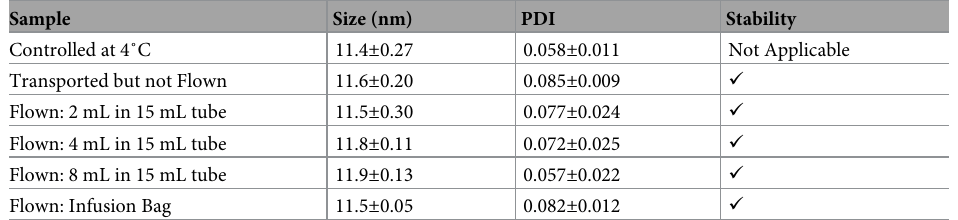
Table 4. Summary of DLS result of Rituximab at different storage